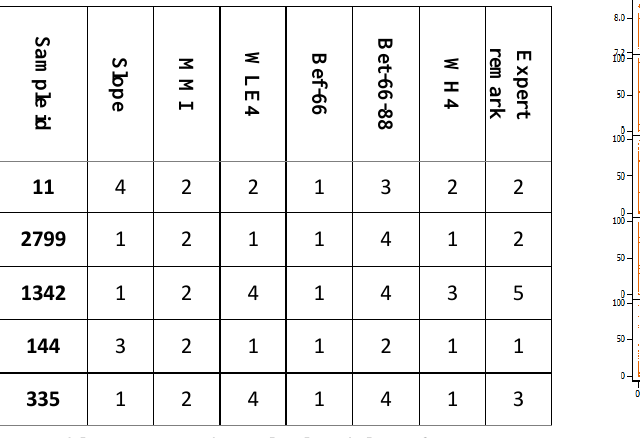
Table 1. Seismic physical vulnerability information classification for the five selected samples